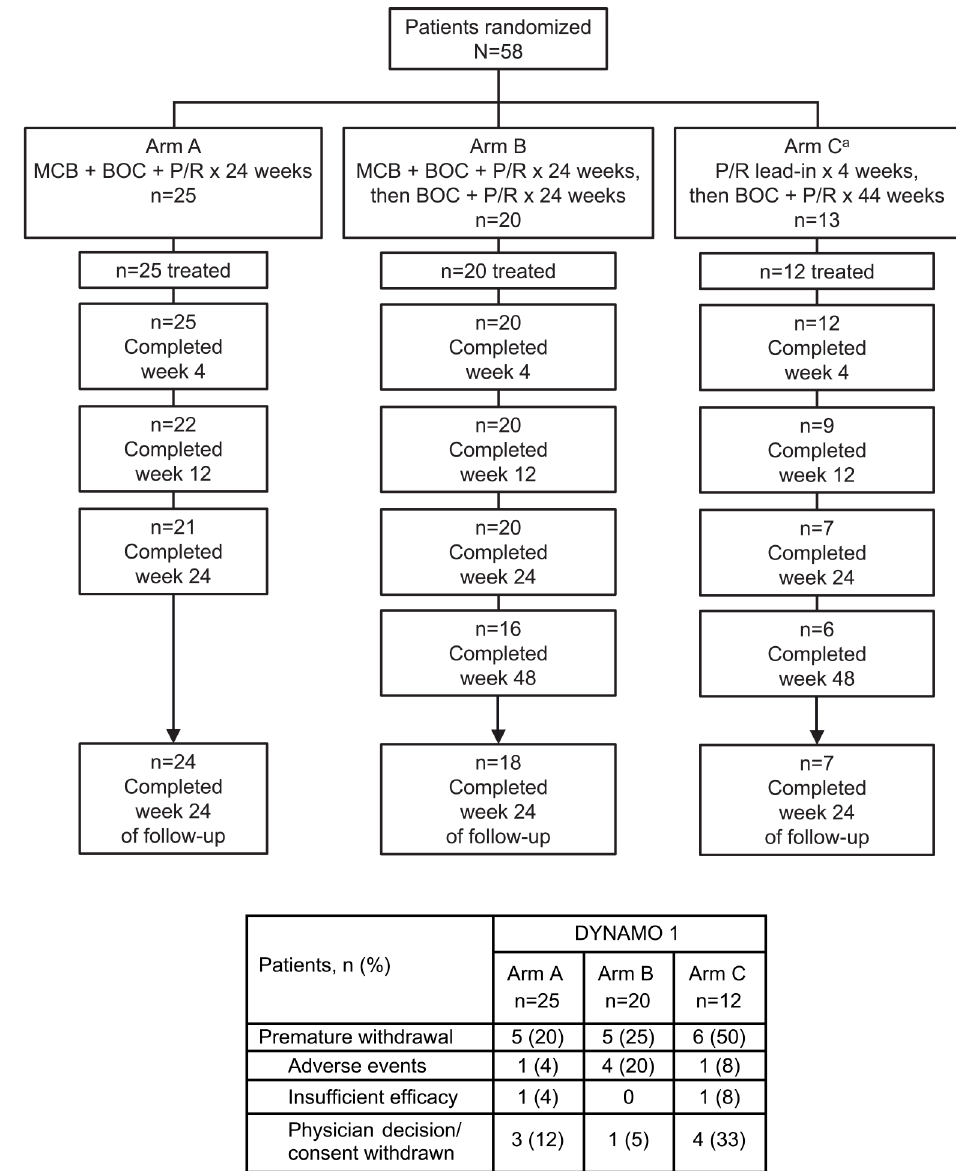
Fig 1. Patient disposition in DYNAMO 1. BOC, boceprevir; MCB, mericitabine; P/R, peginterferon alfa-2a + ribavirin.